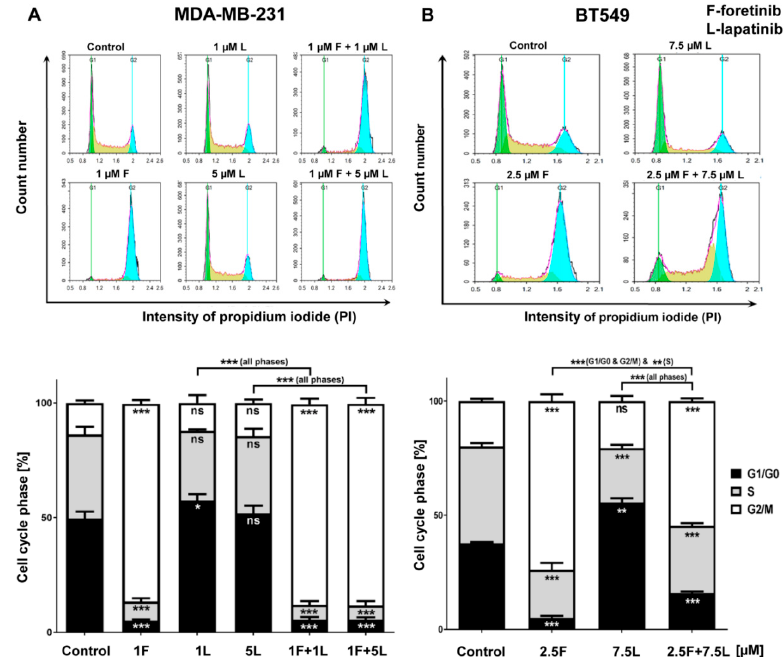
Figure 3. Effect of foretinib, lapatinib, or their combination on cell cycle phases in TNBC cell lines. Cell cycle distribution analysis was performed in ( A ) MDA-MB-231 and ( B ) BT549 cells that were untreated or treated with HGF, EGF, and the inhibitors at the indicated concentrations. Representative histograms as well as graphs are shown. The statistical significance was assessed versus the